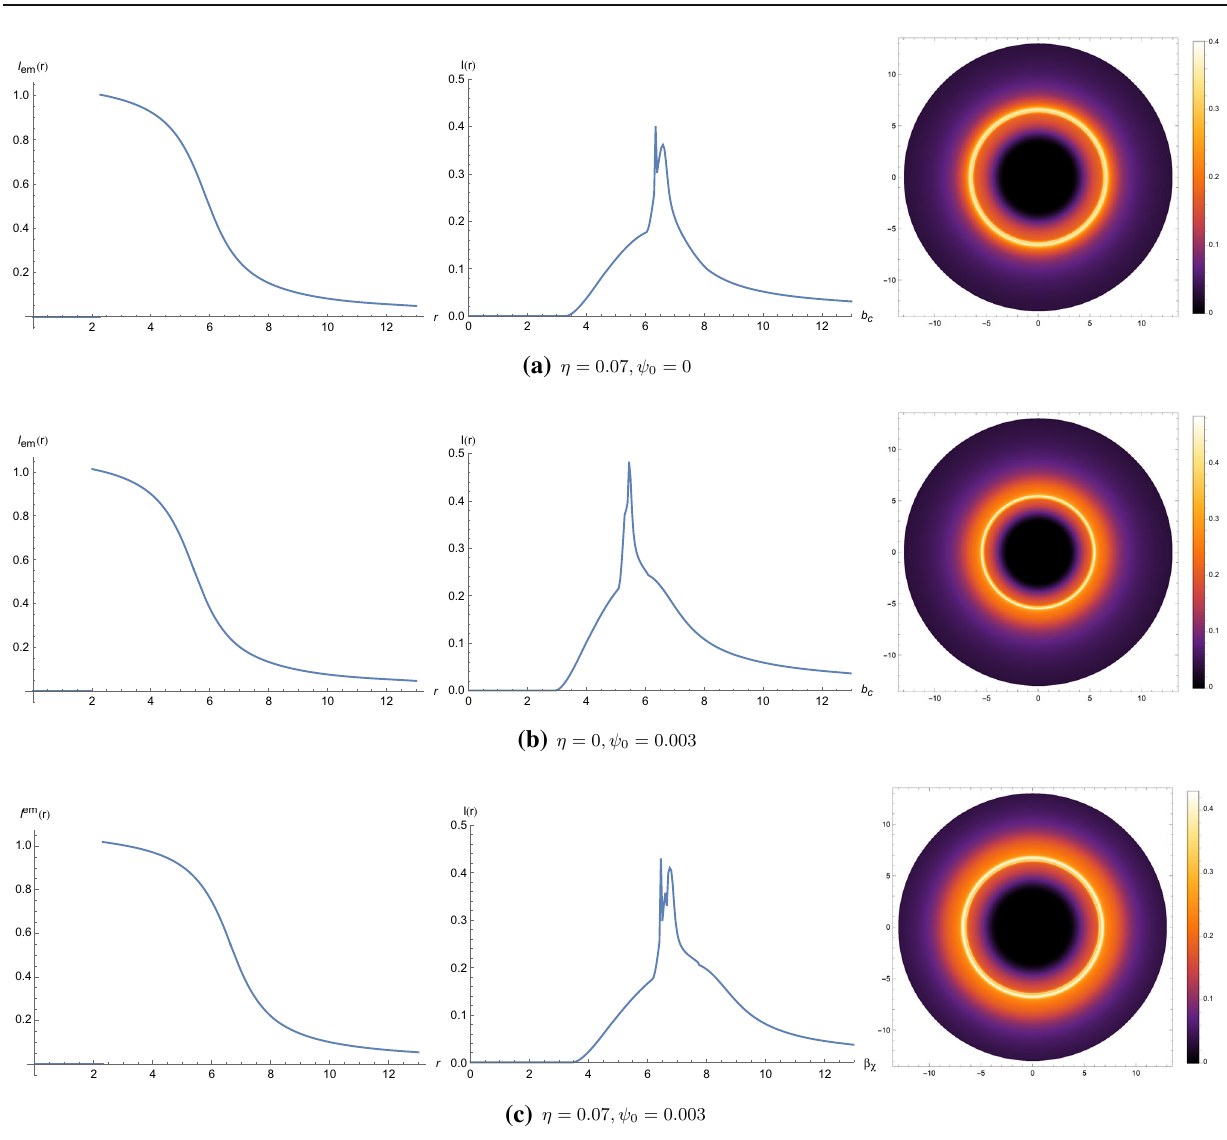
Fig. 7 Observational appearances of the thin disk for the function I (cid:5)(cid:5)(cid:5)